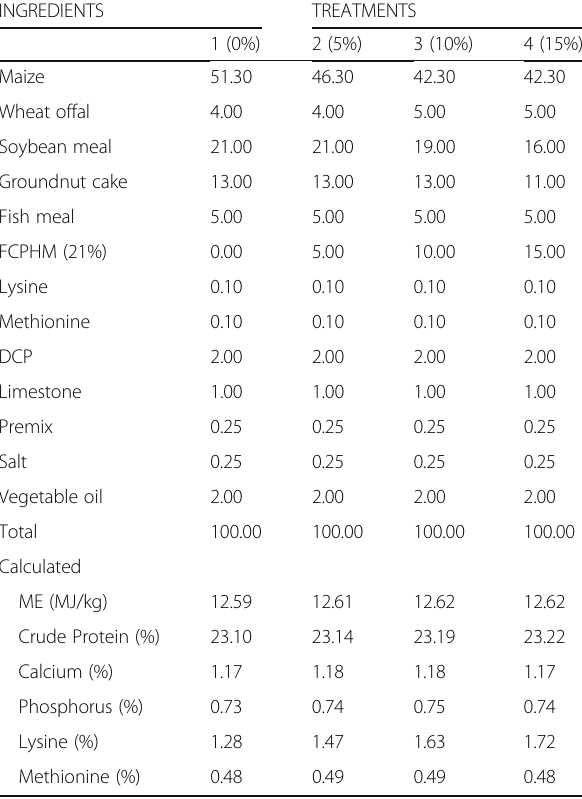
Table 2 Gross composition of the experimental finisher diets